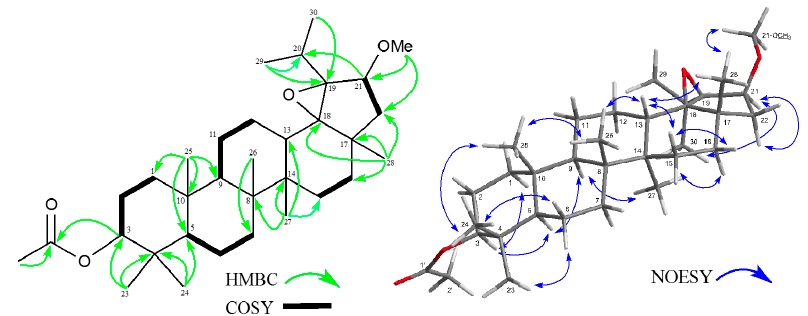
Figure 2. Key HMBC, COSY and NOESY correlations for 1 .